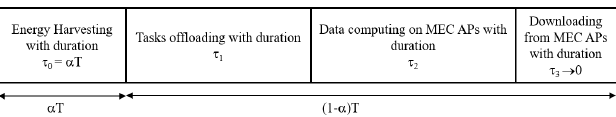
Figure 2. Time flowchart of the considered RF EH NOMA MEC